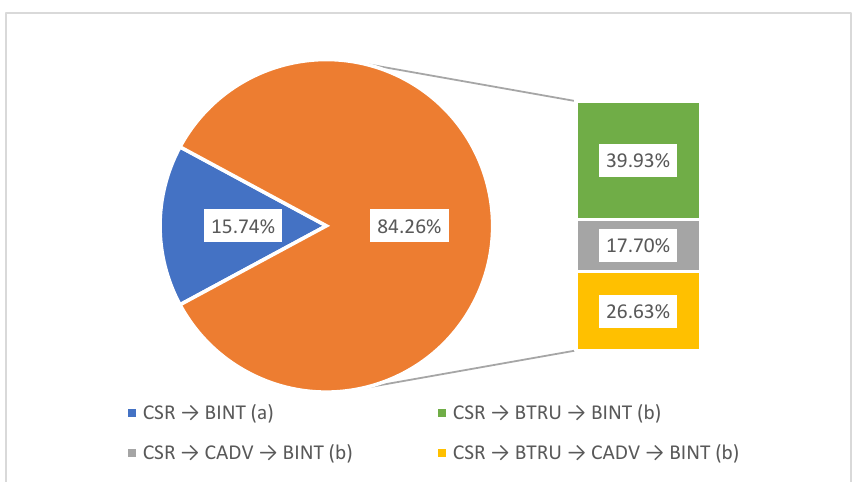
Figure 3. VAF the direct and indirect effects of perceived CSR on competitive advantage. Note: (a) = VAF the direct effect; (b) = VAF the specific indirect effect.